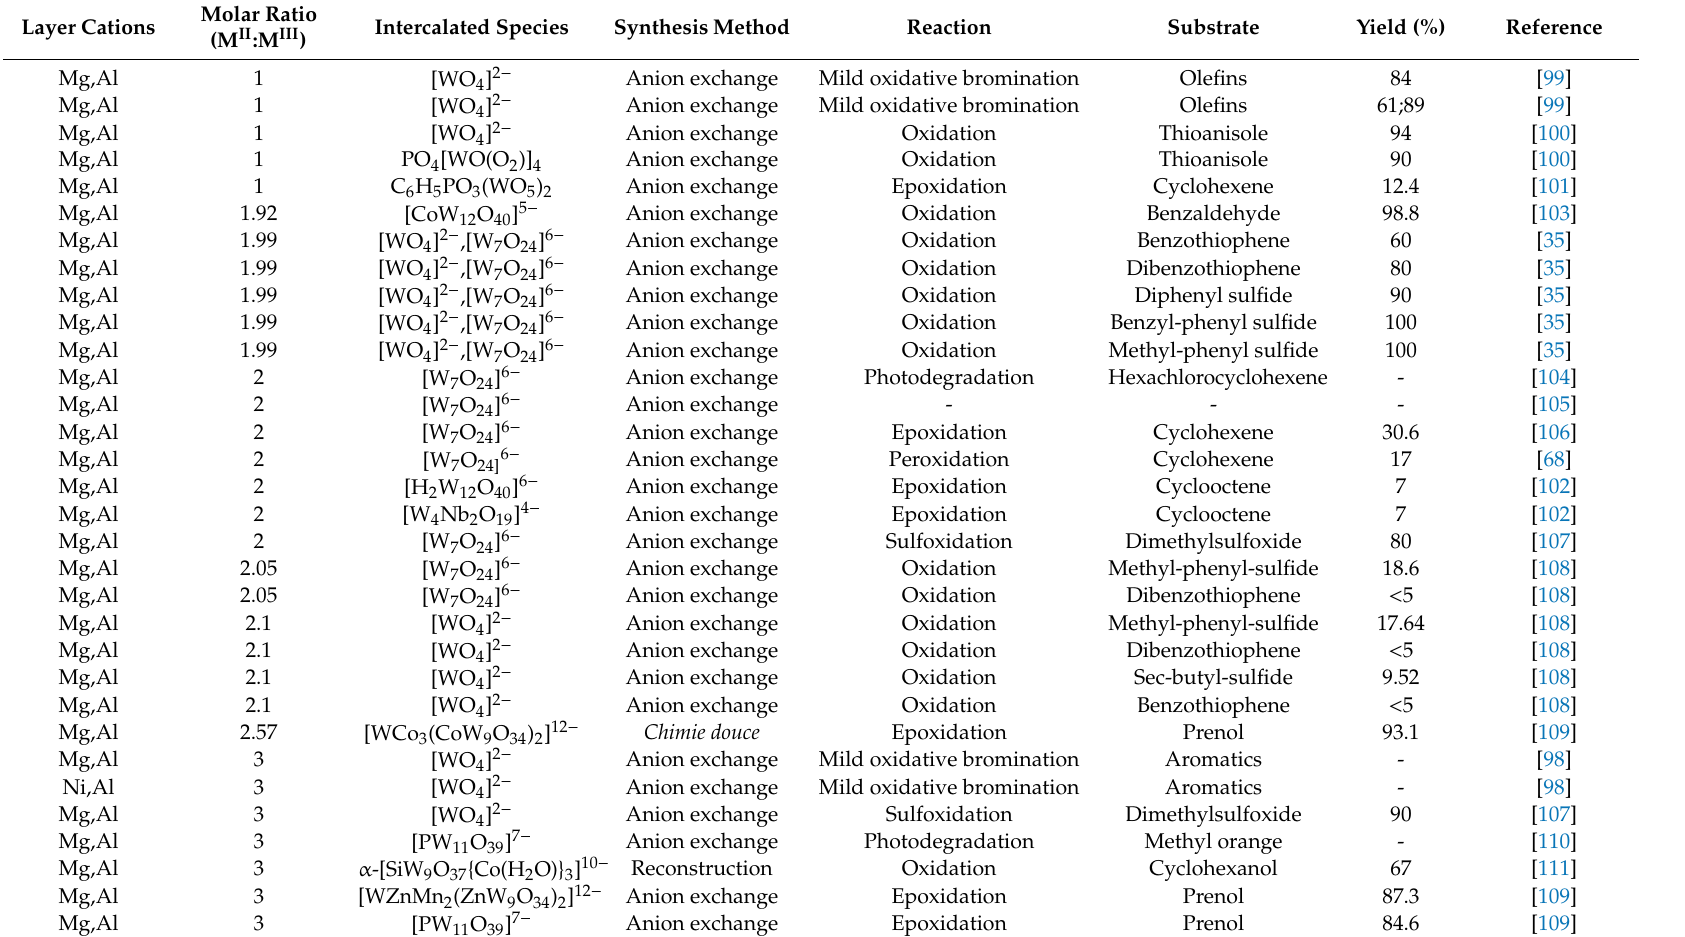
Table 9. Summary of LDH with intercalated tungsten-based